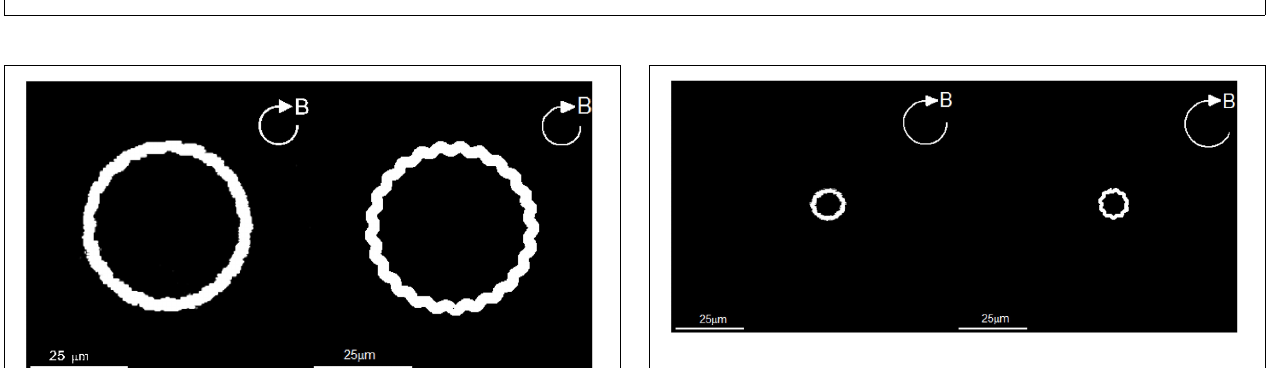
FIGURE 7 | The swimming trajectories of a rod-shaped magnetotactic bacterium under the influence of a rotating magnetic field (Equation 39) with B 0 = 4 . 00 × 10 − 4 T and (cid:2) 0 = 6 . 28/s. The left panel is recorded in our laboratory experiment with a charge-coupled device camera while the right panel shows a numerical solution of the twelve coupled equations using the parameters listed in Table 2